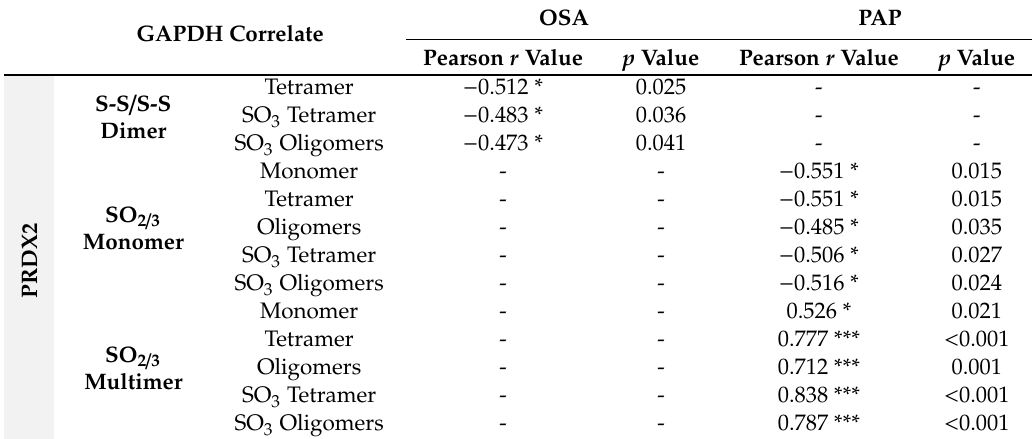
Table 3. Correlation between peroxiredoxin-2 (PRDX2) and GAPDH redox–oligoforms in OSA before (t0) and after six months of PAP treatment